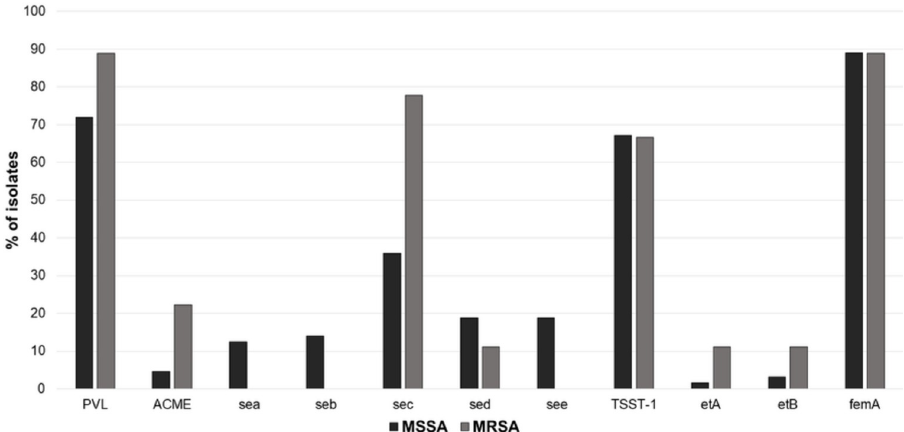
Fig 2. Frequency of virulence factors of S . aureus isolates. ( PVL: Panton-Valentine Leucocidin; ACME: arginine catabolic mobile element; SEA, SEB, SEC, SED, SEE: staphylococcal enterotoxin genes A-E; TSST-1: toxic shock syndrome toxin 1; ETA and ETB: exfoliative toxin genes A and B; FemA: amino acyltransferase femA gen).